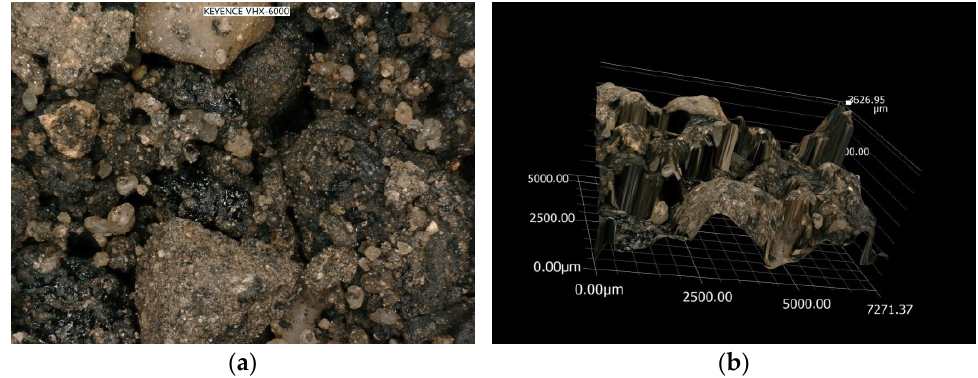
Figure 9. Microscopic image of granulate of two fractions: ( a ) surface image with visible grains and ( b ) spatial image of the RAP sample surface.